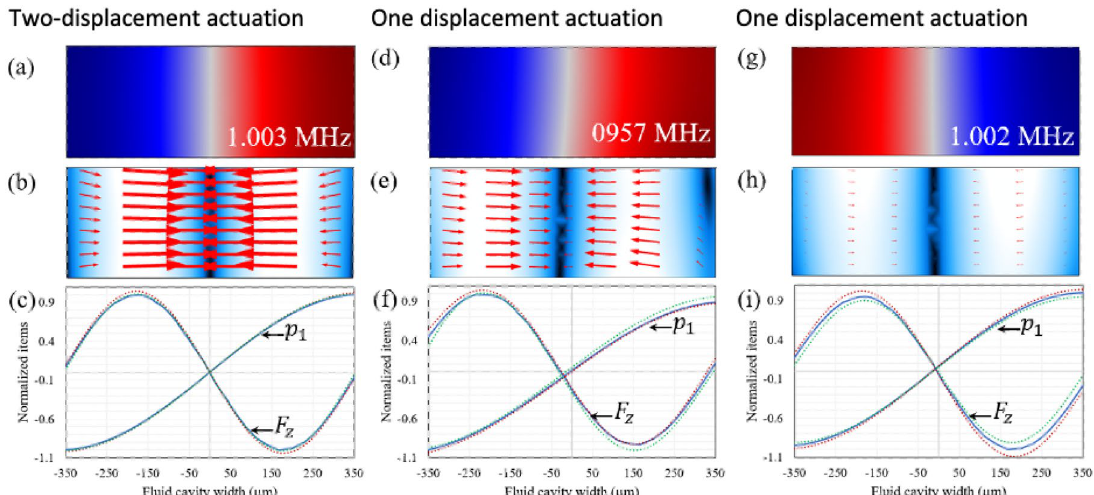
Figure 2. The acoustic pressure fields and resonances of aluminum microchannels. ( a ) The surface plot of the anti-symmetric acoustic pressure (red (− 45 kPa) to blue (45 kPa)), ( b ) the surface and vector plots of the acoustic radiation force (black (0 pN) to white (500 pN)), and ( c ) the line plot of the horizontal acoustic radiation force and the corresponding acoustic pressure along three lines passing the fluid cavity’s cross section in three different heights (red dotted curve for the top line (0.95 H f ), blue solid curve for the center line (0.5 H f ) and green dotted curve for the bottom line (0.05 H f )) for the resonance frequency of 1.003 MHz for two- displacement actuation. ( d ) the surface plot of the acoustic pressure (blue (− 17 kPa) to red (15 kPa)), ( e ) the surface and vector plots of the acoustic radiation force (black (0 pN) to white (250 pN)), and ( f ) the line plot of the acoustic pressure and horizontal acoustic radiation force for the resonance frequency of 0.957 MHz for one- displacement actuation. ( g ) the surface plot of the acoustic pressure (red (− 41 kPa) to blue (42 kPa)), ( h ) the acoustic radiation force (black (0 pN) to white (52 pN)), and ( i ) the line plot of acoustic pressure and horizontal acoustic radiation force for the resonance frequency of 1.002 MHz for one-displacement